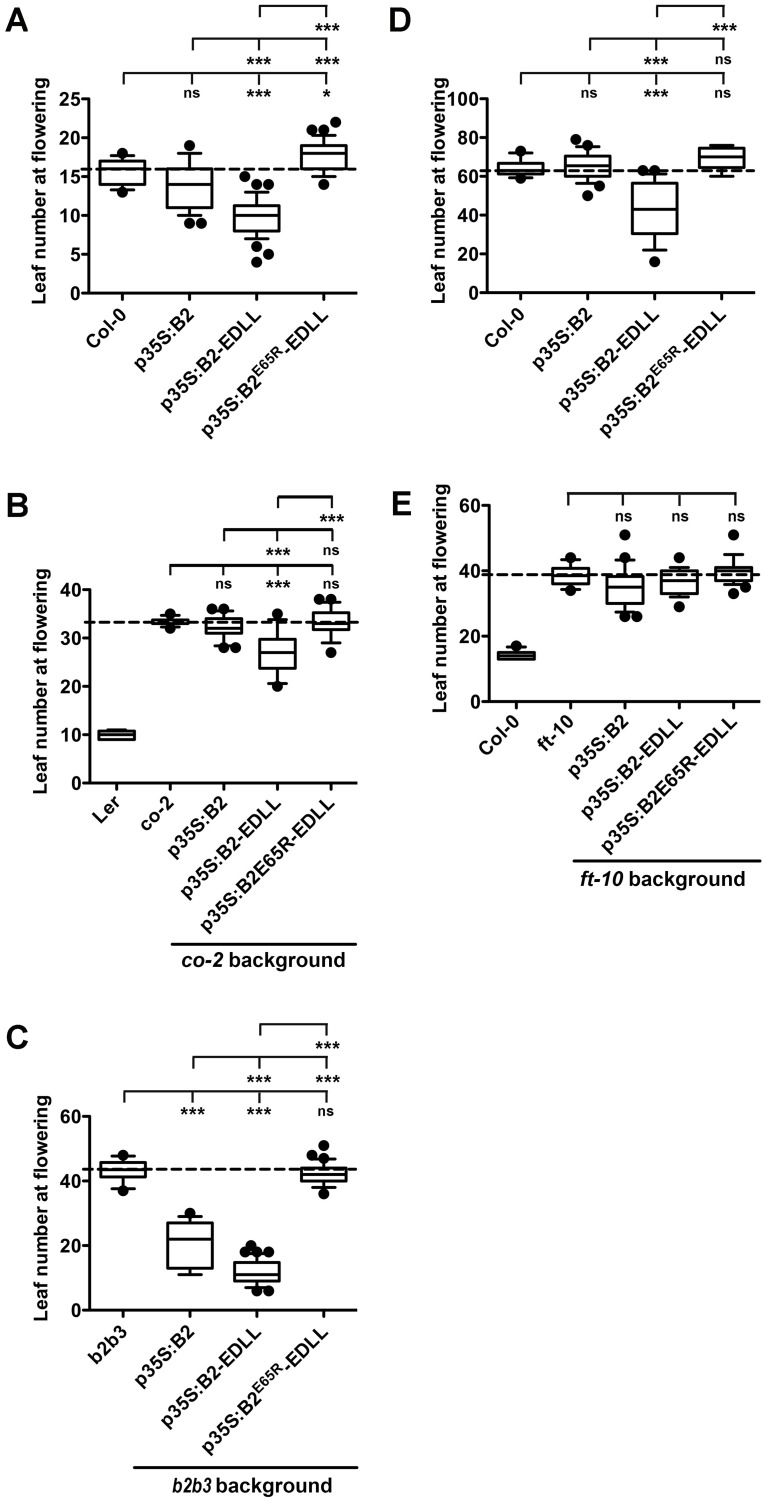
NF-YB2-EDLL, but not NF-YB2E65R-EDLL, rescues late flowering in an FT-dependent manner.Flowering time quantification for 15–20 randomly selected T1 plants of p35S:NF-YB2, p35S:NF-YB2-EDLL, and p35S:NF-YB2E65R-EDLL in A) Col-0 B) co-2 C) b2b3 D) short days E) ft-10. Asterisks represent significant differences derived from one-way ANOVA (P < 0.05) followed by Bonferroni’s multiple comparison tests (*** P < 0.001; * P < 0.05).